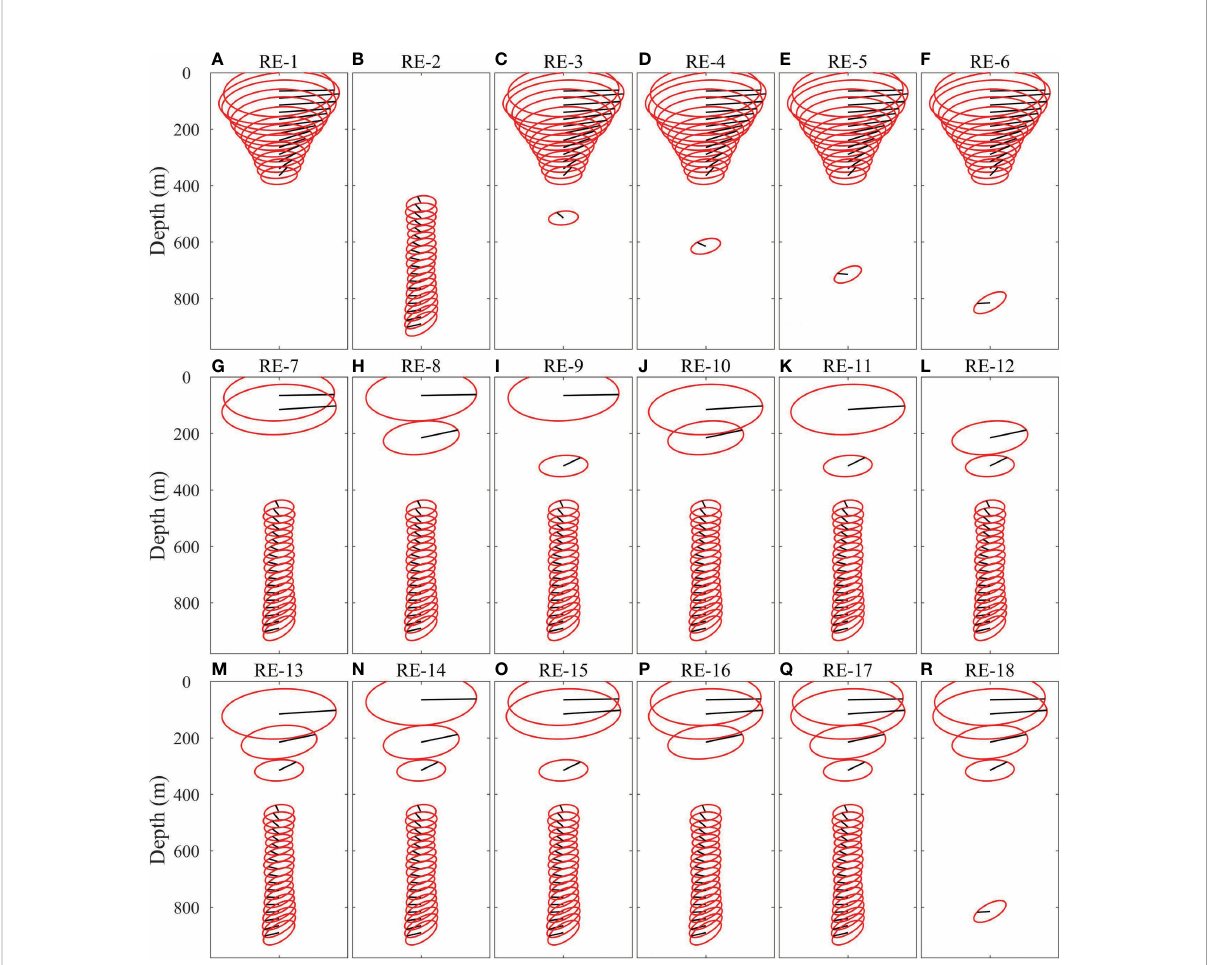
FIGURE 4 (A – R) Observed M 2 tidal currents in RE-1 to RE-18. The abscissa range is -0.2 m/s to 0.2 m/s. The depth layers of the virtual CMs measured by up-looking ADCP are 50, 100, 200 and 300 m, respectively. The depth layers of the virtual CMs measured by down-looking ADCP are 500, 600, 700 and 800 m,